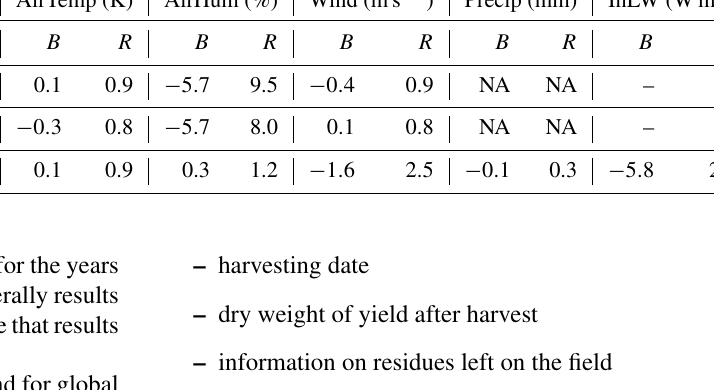
Table 12. Uncertainty estimates for weather time series gap filling expressed as pairs of bias ( B ) and RMSE ( R ). Missing data are denoted by NA; “–” marks cases where there were no gaps or no data. Methods are described in the text. For abbreviations see Table A7.